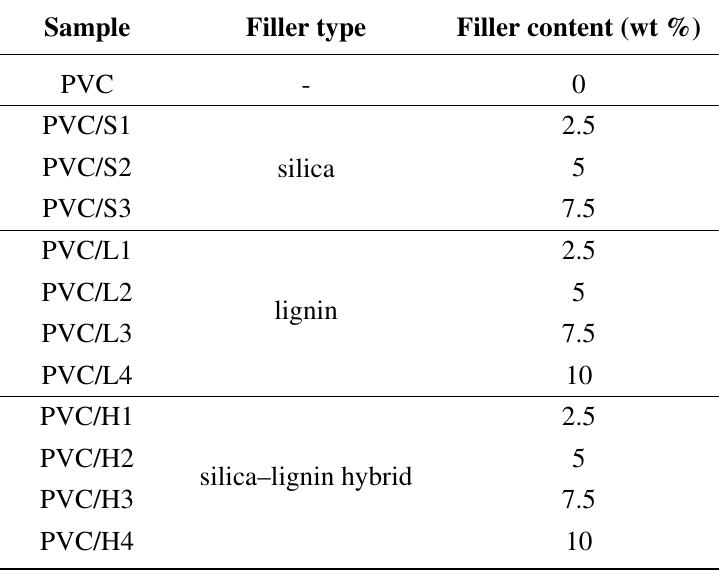
Table 1. The composition of the PVC-based